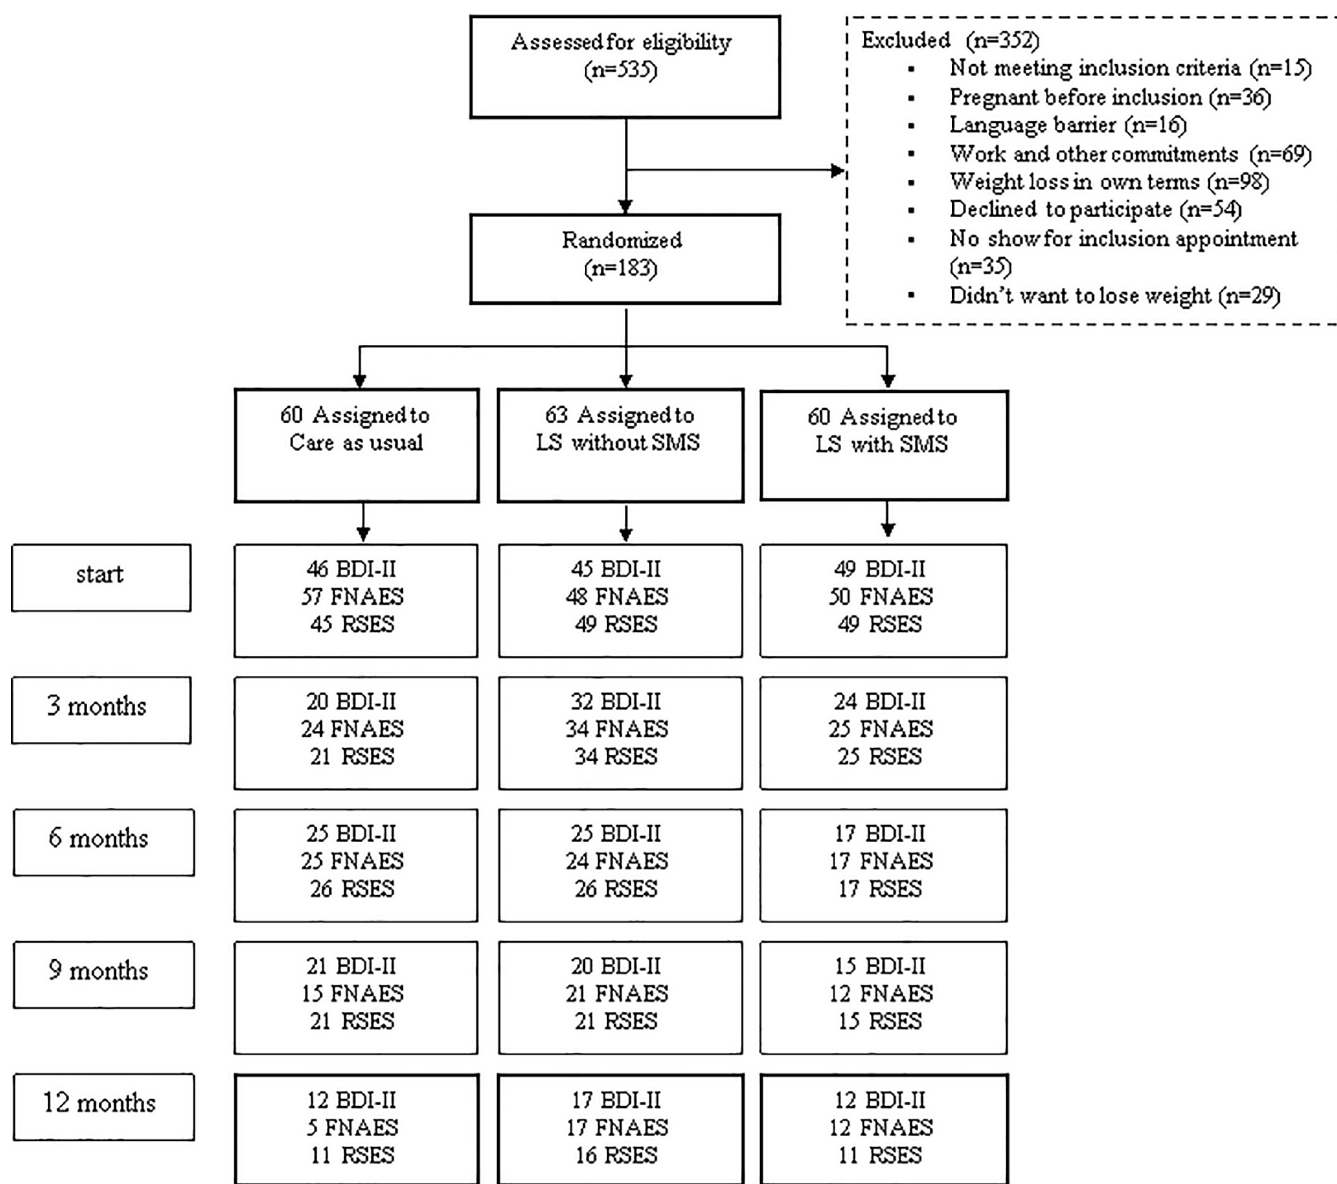
Fig 1. Consort flowchart. BDI-II = depression, RSES = self-esteem, FNAES = body